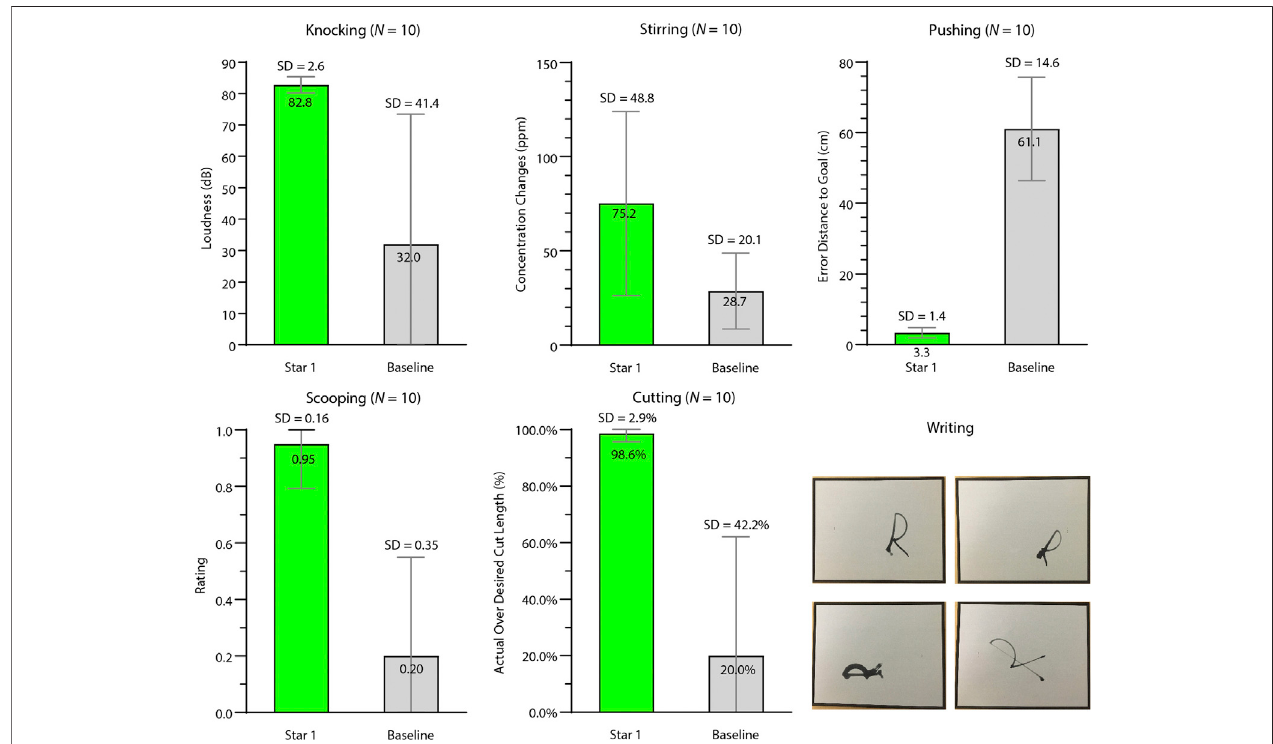
FIGURE 7 | Results of learning source tools with source manipulanda (Star 1). We compared Star 1 (green) performance against a baseline (gray) for knocking, stirring, pushing, scooping, and cutting. The pictures at the bottom right show the demonstrations of the writing task. The top left is an “ R ” using the same scale and rotation as the training sample. The top right, bottom left, and bottom right “ R ” s used the following scales and orientations: scale (cid:2) 1.0, orientation (cid:2) 270 ° ; scale (cid:2) 0.8, orientation (cid:2) 30 ° ; scale (cid:2) 1.5, orientation (cid:2) 300 °